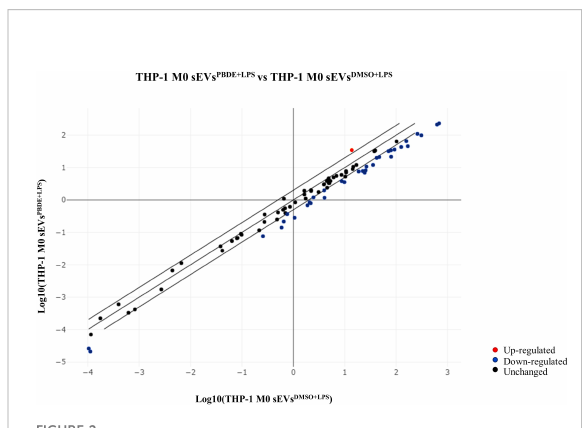
FIGURE 2 Scatterplot of miRNA expression in M(0) THP-1 macrophage-like cells treated with sEVs PBDE+LPS . CT values obtained from three independent experiments (M(0) THP-1 macrophage-like treated with sEVs PBDE+LPS vs controls) were analyzed using the GeneGlobe miRCURY LNA miRNA PCR Data Analysis tool. Blue dots show down-regulated miRNAs (fold change <0.5), red is for up-regulated miRNA (fold change >2), and black indicates unchanged miRNAs with respect to control cells.